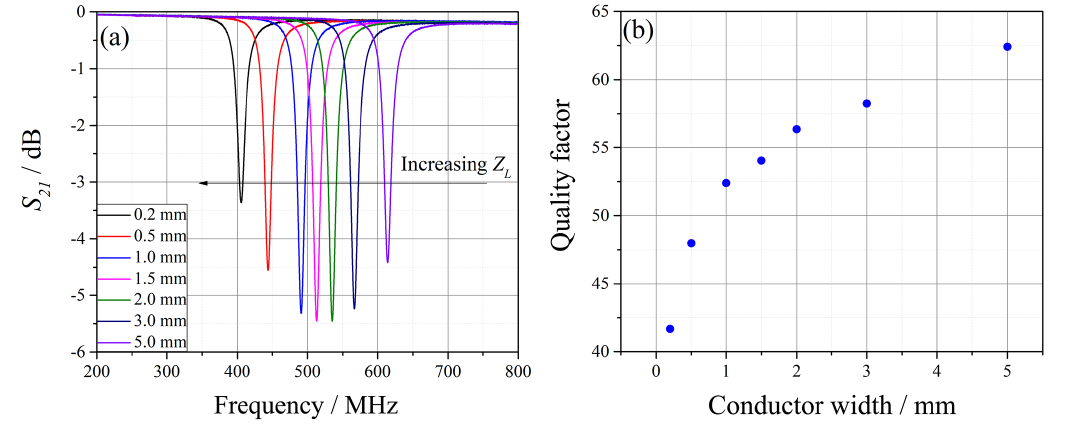
Figure 15. Measurement results for unloaded resonators with different wave impedances of the resonator structure: (a) transmission mea- surement; (b) quality factor.